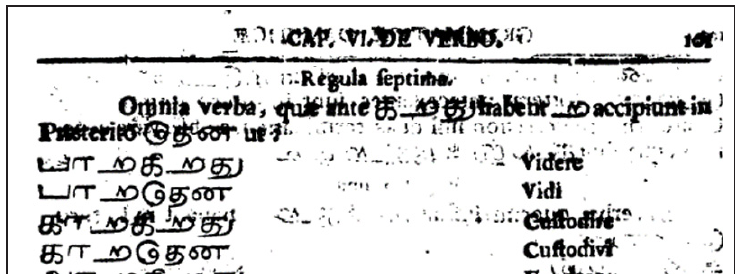
Figure 14: Ziegenbalg 1716: 101,